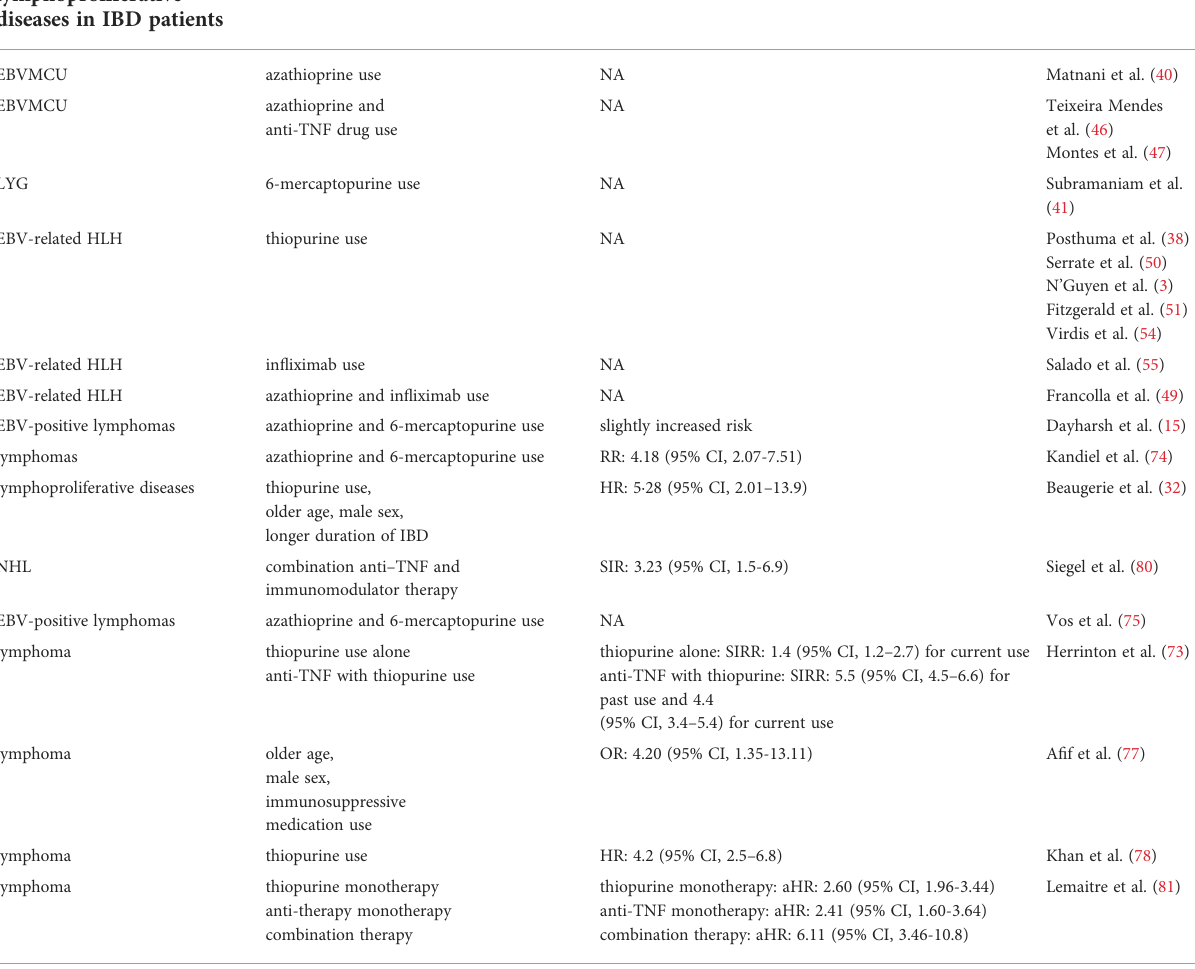
TABLE 3 Risk factors for lymphoproliferative diseases in IBD patients. Complicated